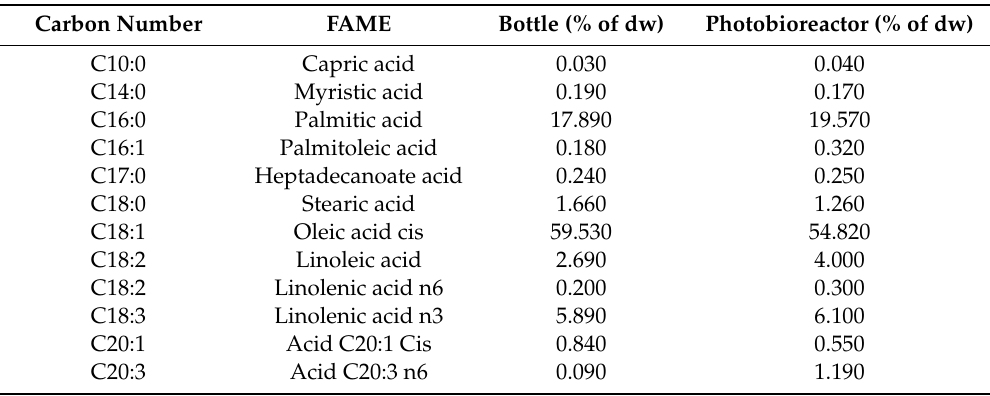
Table 5. The composition and content of